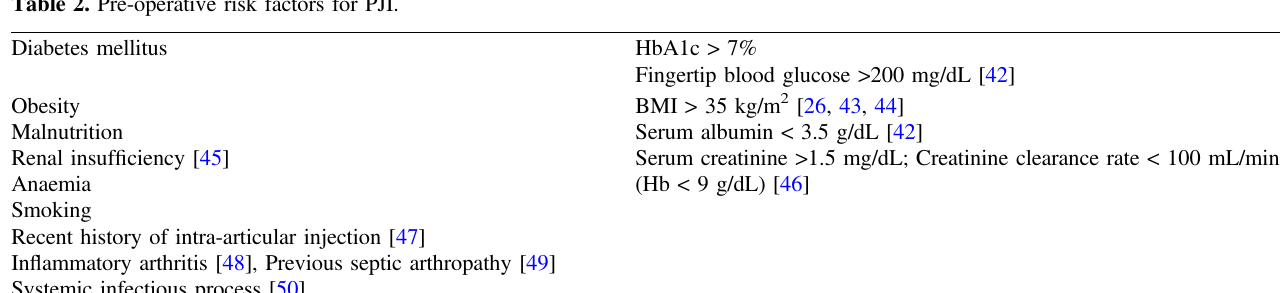
Table 2. Pre-operative risk factors for PJI. Diabetes